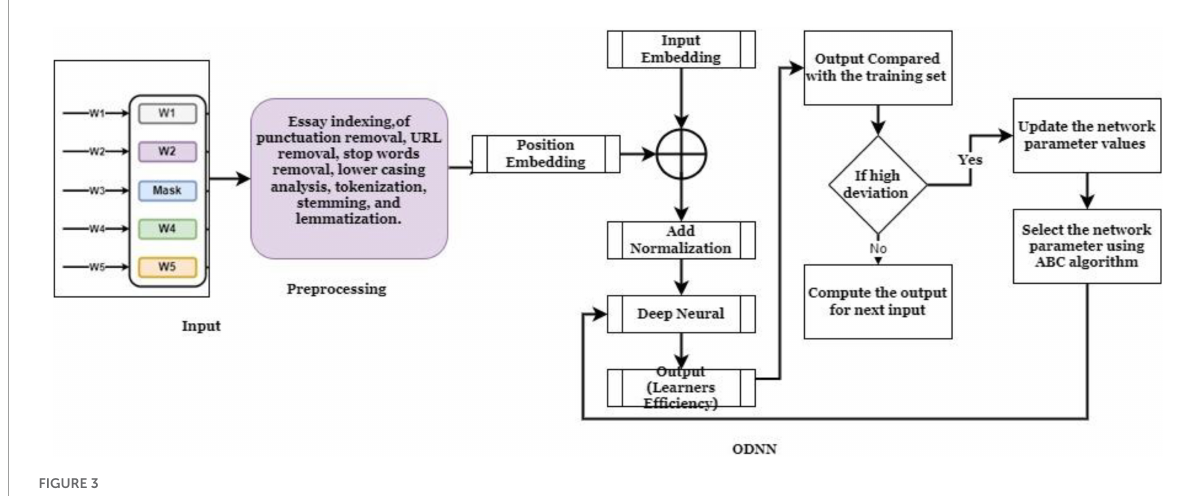
FIGURE3 Working process of ODNN.